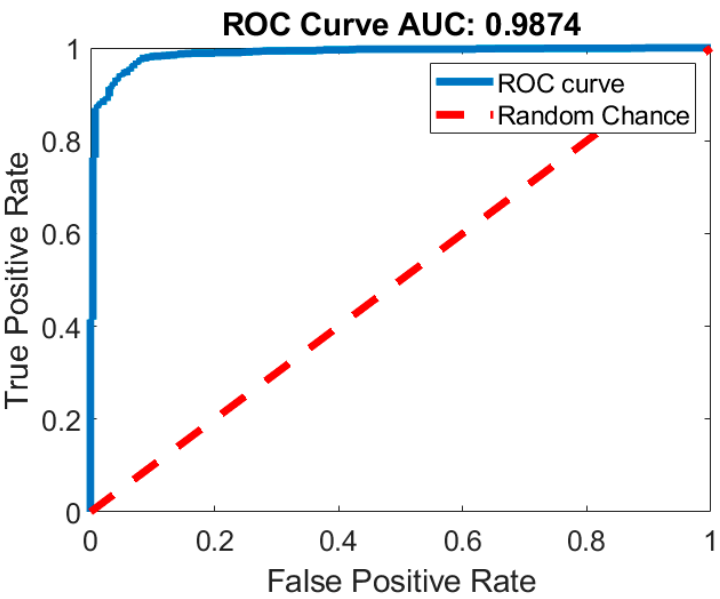
Figure 4. ROC of the proposed cotton leaf classification model.